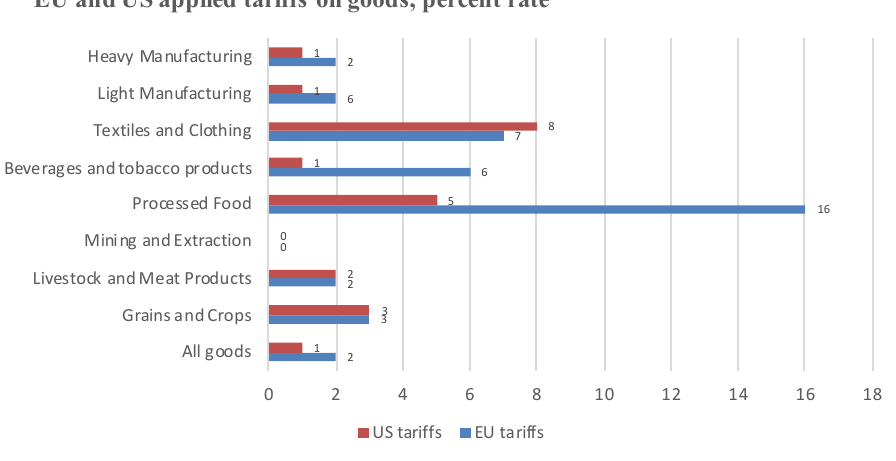
Figure 2. Applied MFN tariff on transatlantic